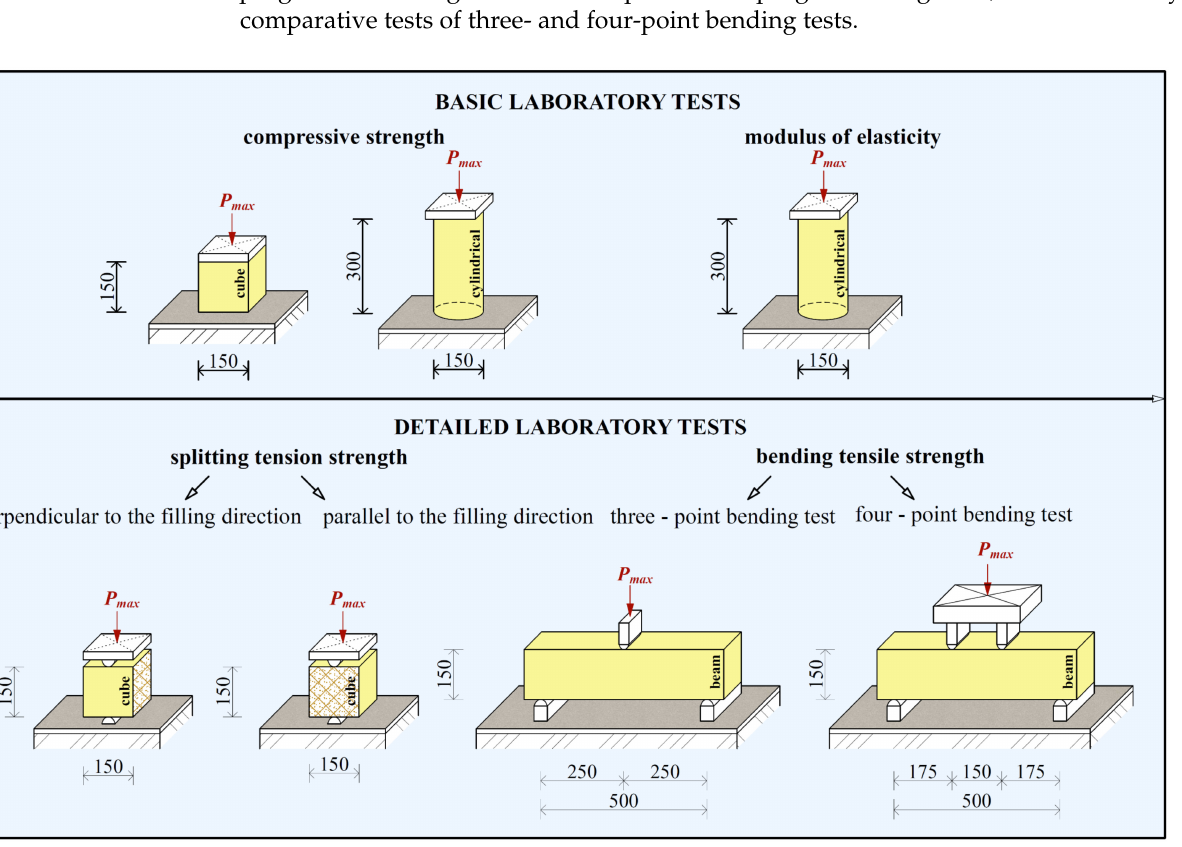
Figure 1. Set of laboratory tests